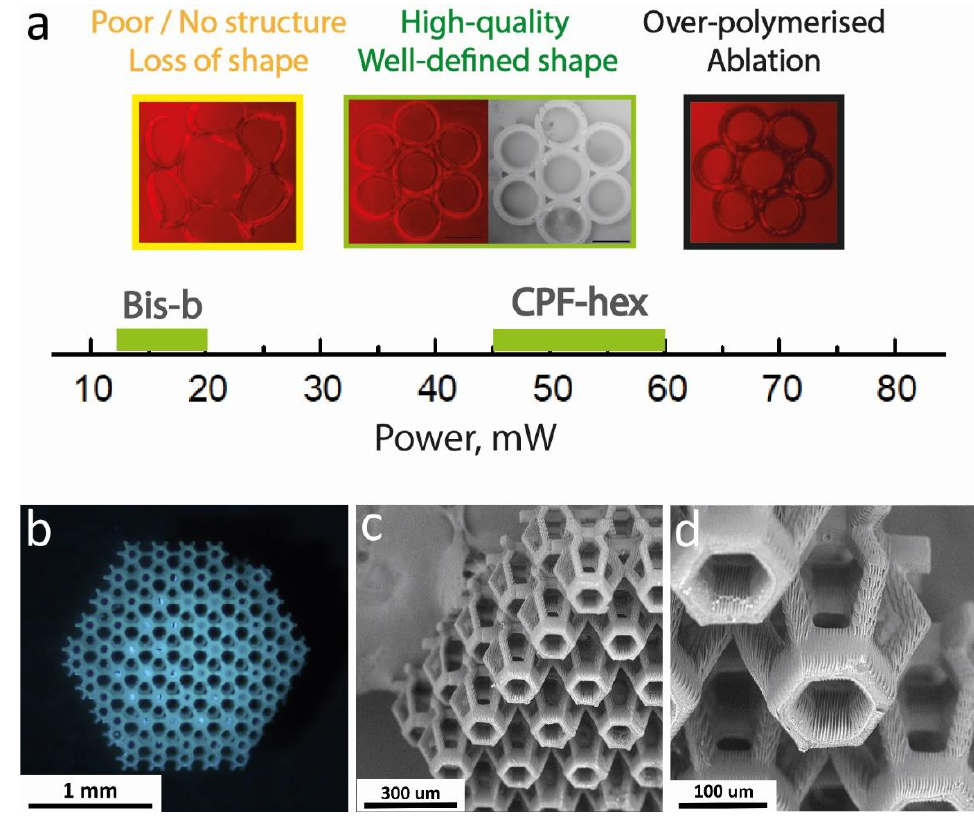
Figure 5. ( a ): The 2PP structuring test results of Bis-b and CPF-hex. The power range required to